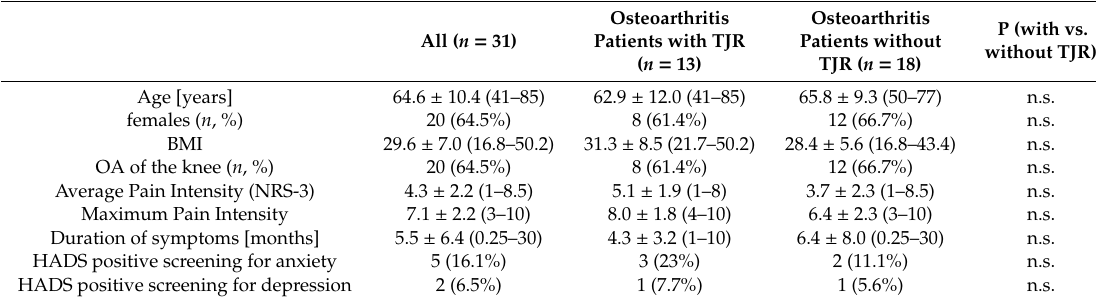
Table 1. Study Population at visit